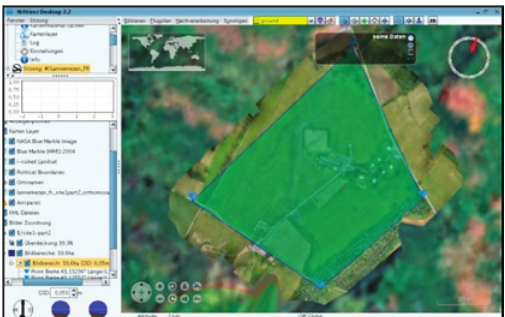
Fig. 8. Imported orthophoto after post-processing from MAVinci Desktop flight planning software (Images …